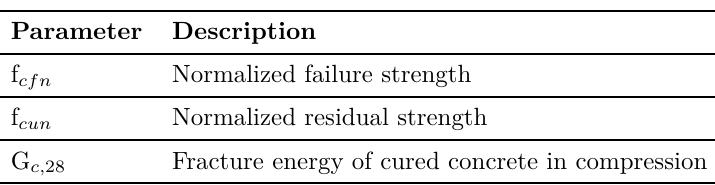
Table 5. Input parameters for strain softening in compression.